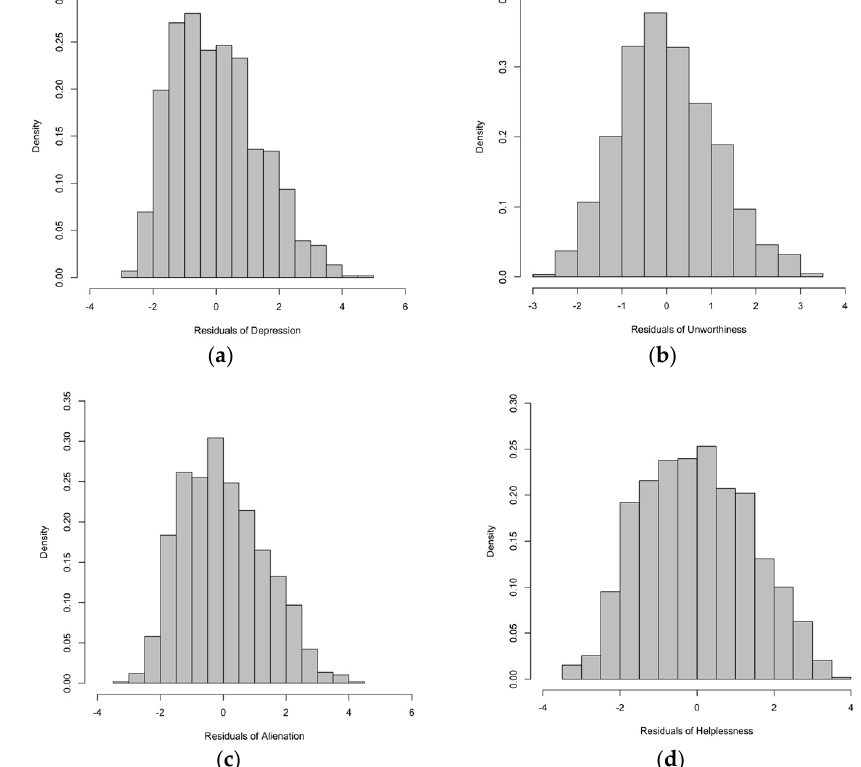
Figure 1. ( a ) Histogram of the residuals of the variable Depression; ( b ) Histogram of the residuals of the variable Unworthiness; ( c ) Histogram of the residuals of the variable Alienation; ( d ) Histogram of the residuals of the variable Helplessness.